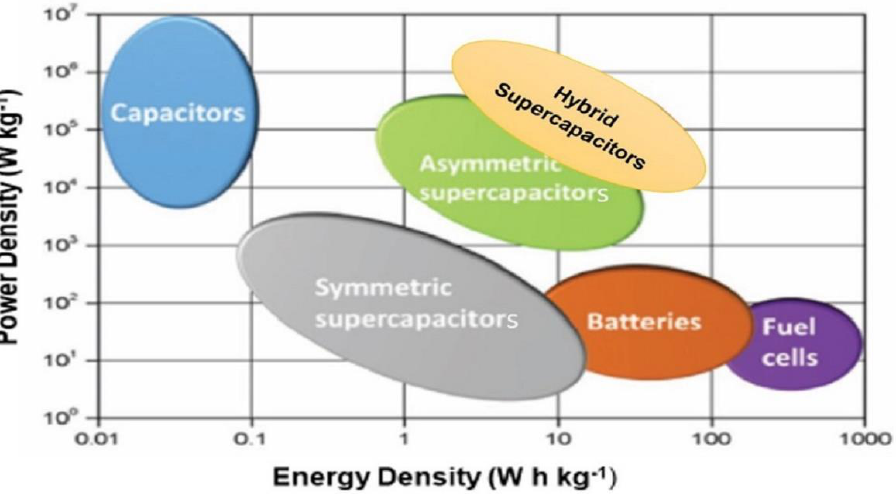
Figure 1. Ragone plot—comparison of the performance of different energy storage devices. Repro- duced with permission [5]. Copyright 2017, Wiley-V.CH.